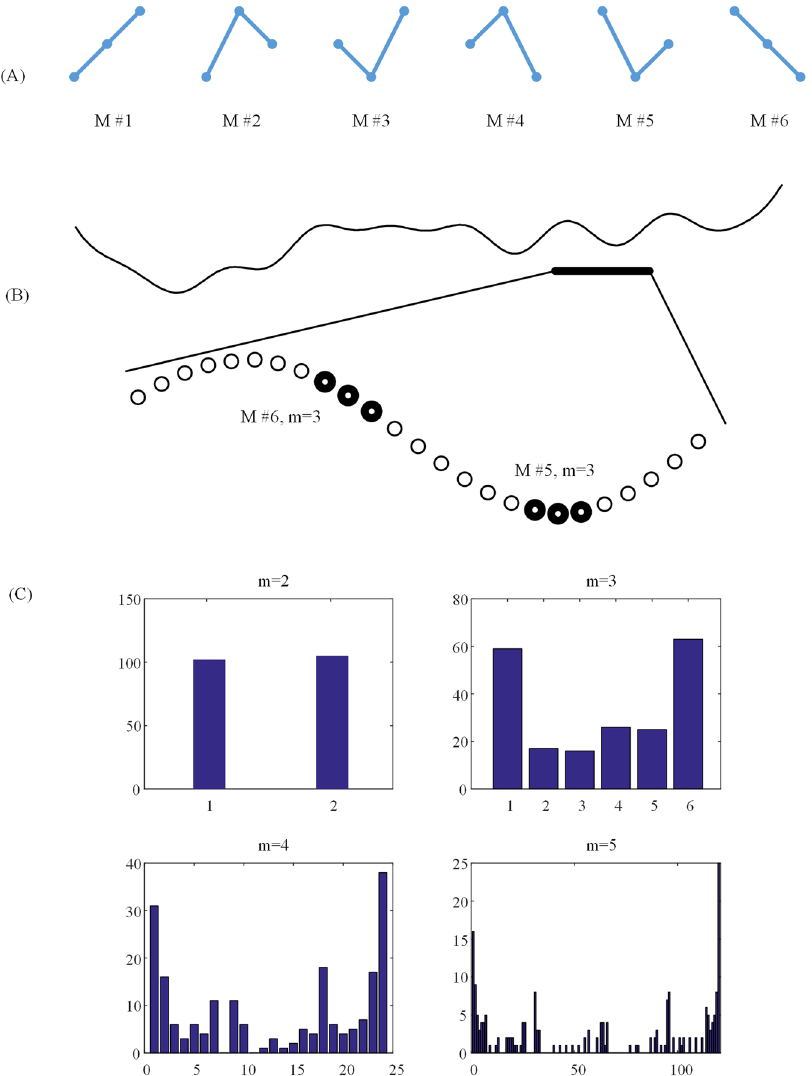
= m 2 , 3, 4 and 5. Horizontal ordinate represents